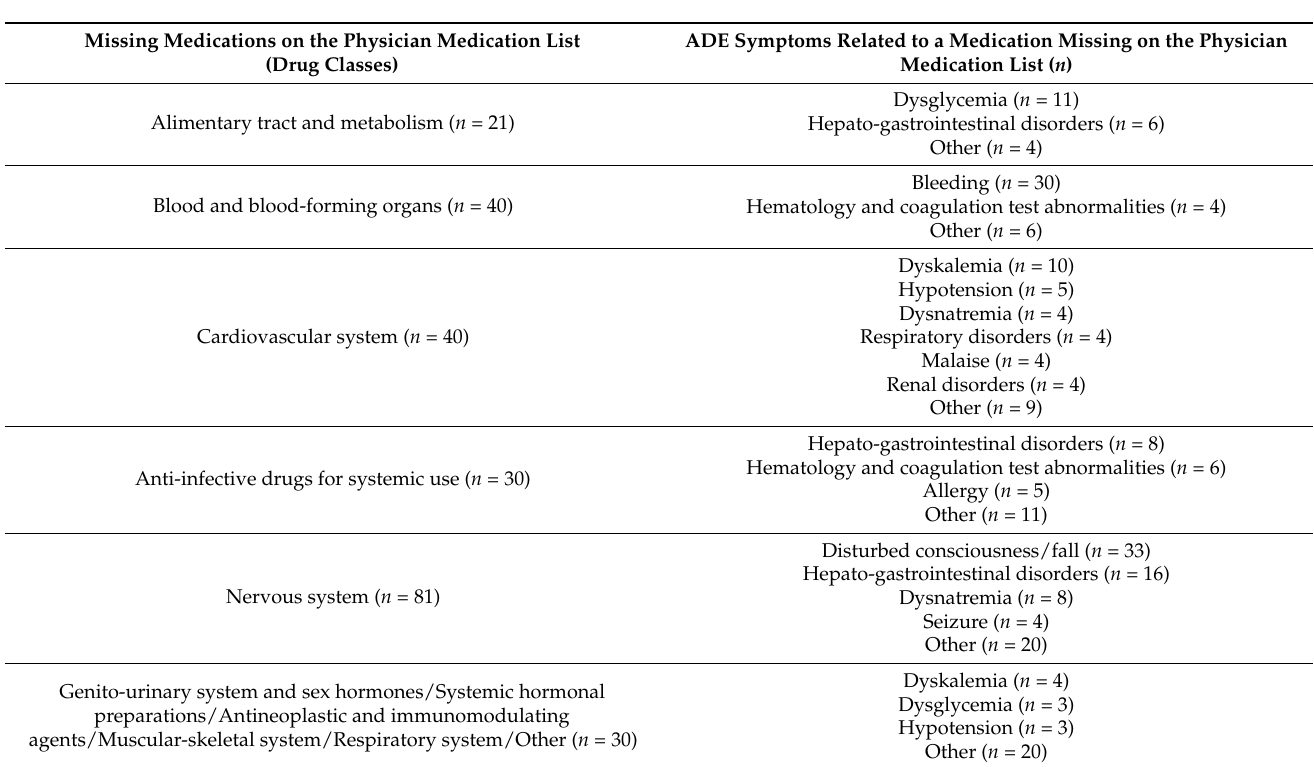
Table 4. Missing medications on the physician medication list, and related adverse drug event symptoms ( n =